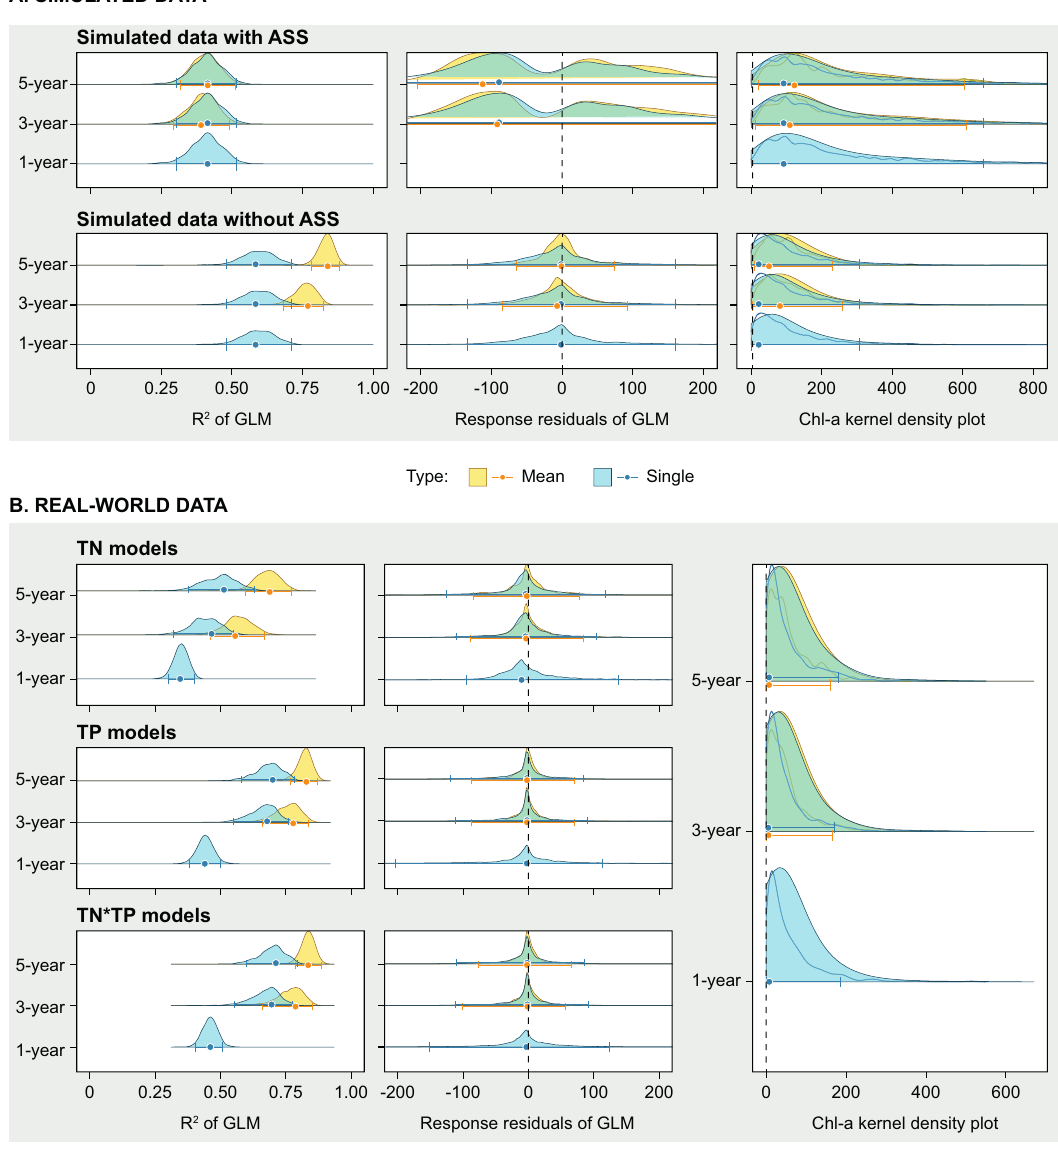
Fig. 3 | Comparison of diagnostic tests for the presence or absence of alter- nativeequilibriaonsimulatedandreal-worlddataatarangeoftimescales. The fi gureshowstheresultsofthethreediagnosticstests(i)changein R 2 ,(ii)patternsin models residuals (single year, 3-year and 5-year means)and (iii) the kernel density plot (high (50 – fi lled) and low (10 – lines) bandwidth) for simulated datasets ( A ) with and without alternative equilibria and for the real-world data ( B ). Panel A demonstrates that there are characteristic patterns of the diagnostic tests for datasets but with and without ASS but that this requires an increase in temporal scaleasthebetween-yearvariationobscuresthepatternsforsingle-yeardata.Panel B shows that real-world data follows the patterns of the simulated dataset with